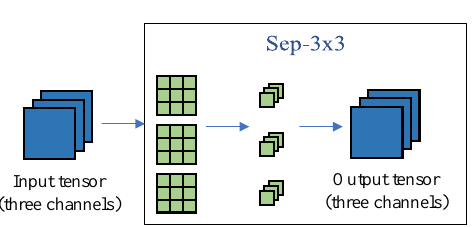
Figure 4. Illustration of the fine-tuning stage. Leaving only the branch with a mask of 1 in each layer and fine-tuning the compressed CNN for several